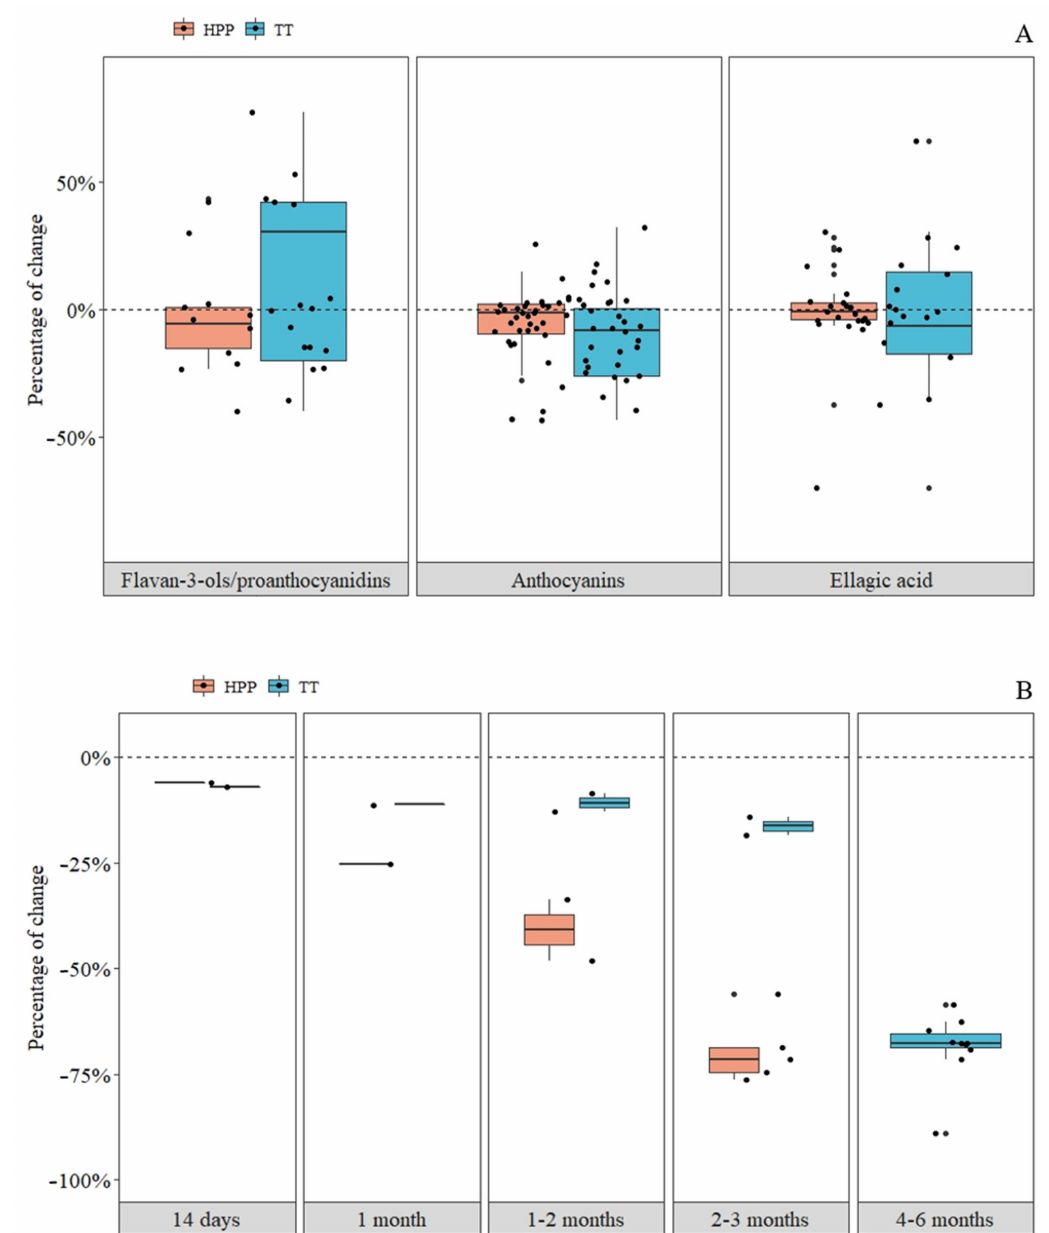
Figure 3. Impact of thermal treatment (TT) and high-pressure processing (HPP) on total